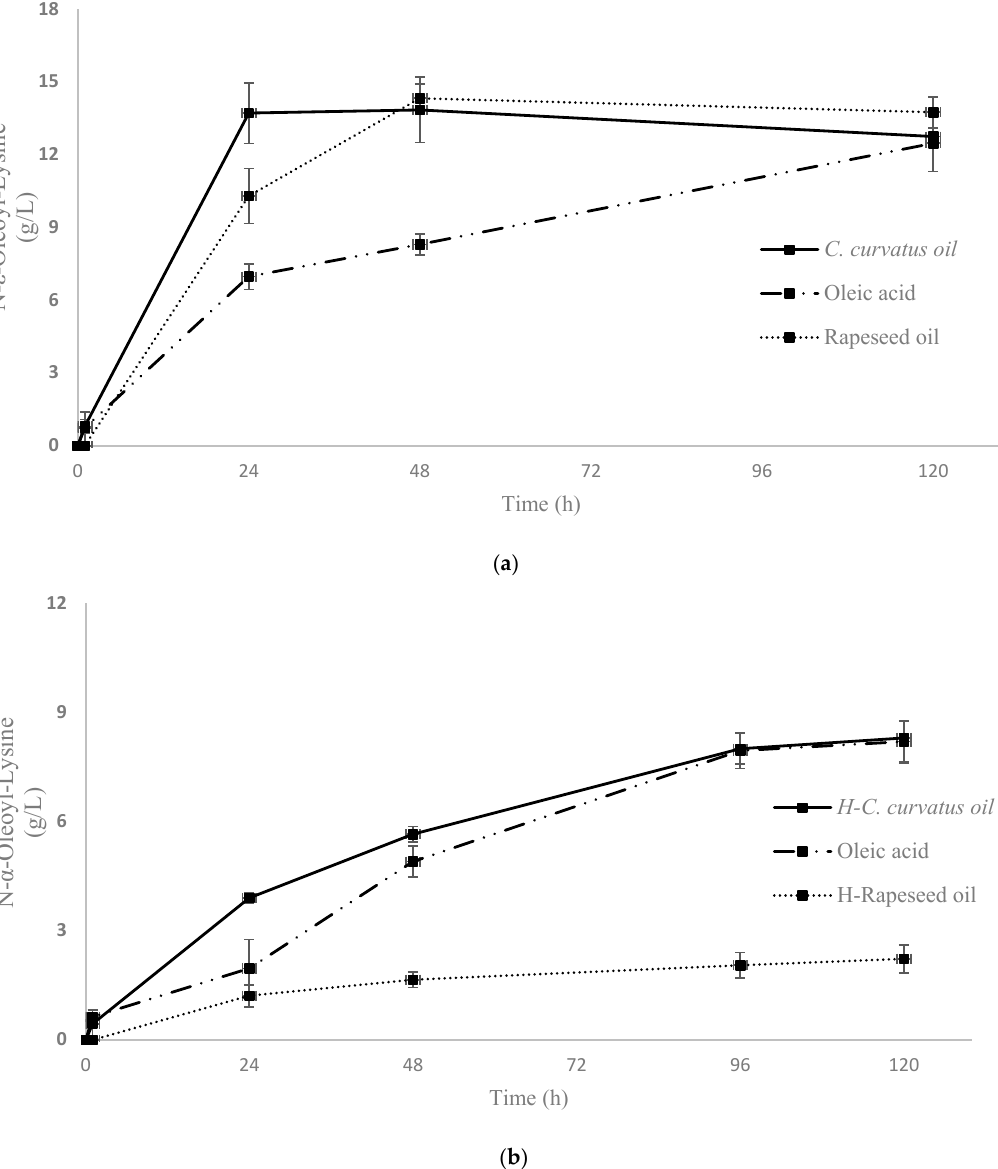
Figure 3. HPLC-MS2 spectrum after fragmentation of the ε -oleoyl-lysine parent ion ( m/z = 410) syn- thesised by CALB. 2.2.2. N-Acylation of Lysine Using Free and Oil-Derived AD by Aminoacylases, in Aqueous Medium After the production and the partial purification of aminoacylases, their final protein concentration was measured at 9 g/L by Bradford assay. Recently isolated aminoacylases from Streptomyces ambofaciens ATCC 23877 were selected for their ability to perform N- acylation of α amino group of amino acids or peptides [31]. Fragmentation of α -oleoyl- lysine led to one major daughter ion ( m/z = 375.4) corresponding to [(Oleoyl-lysine) − 2H 2 O + H + ] and one minor daughter ion ( m/z = 348.35) corresponding to [(Oleoyl-lysine) − H 2 O